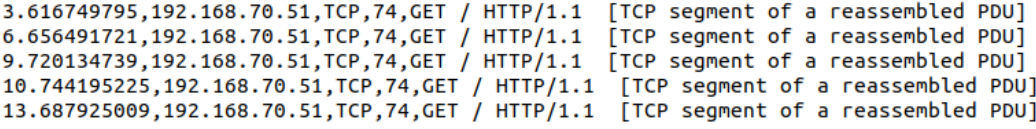
Figure 4. Tracers from the Slowloris attack after applying the